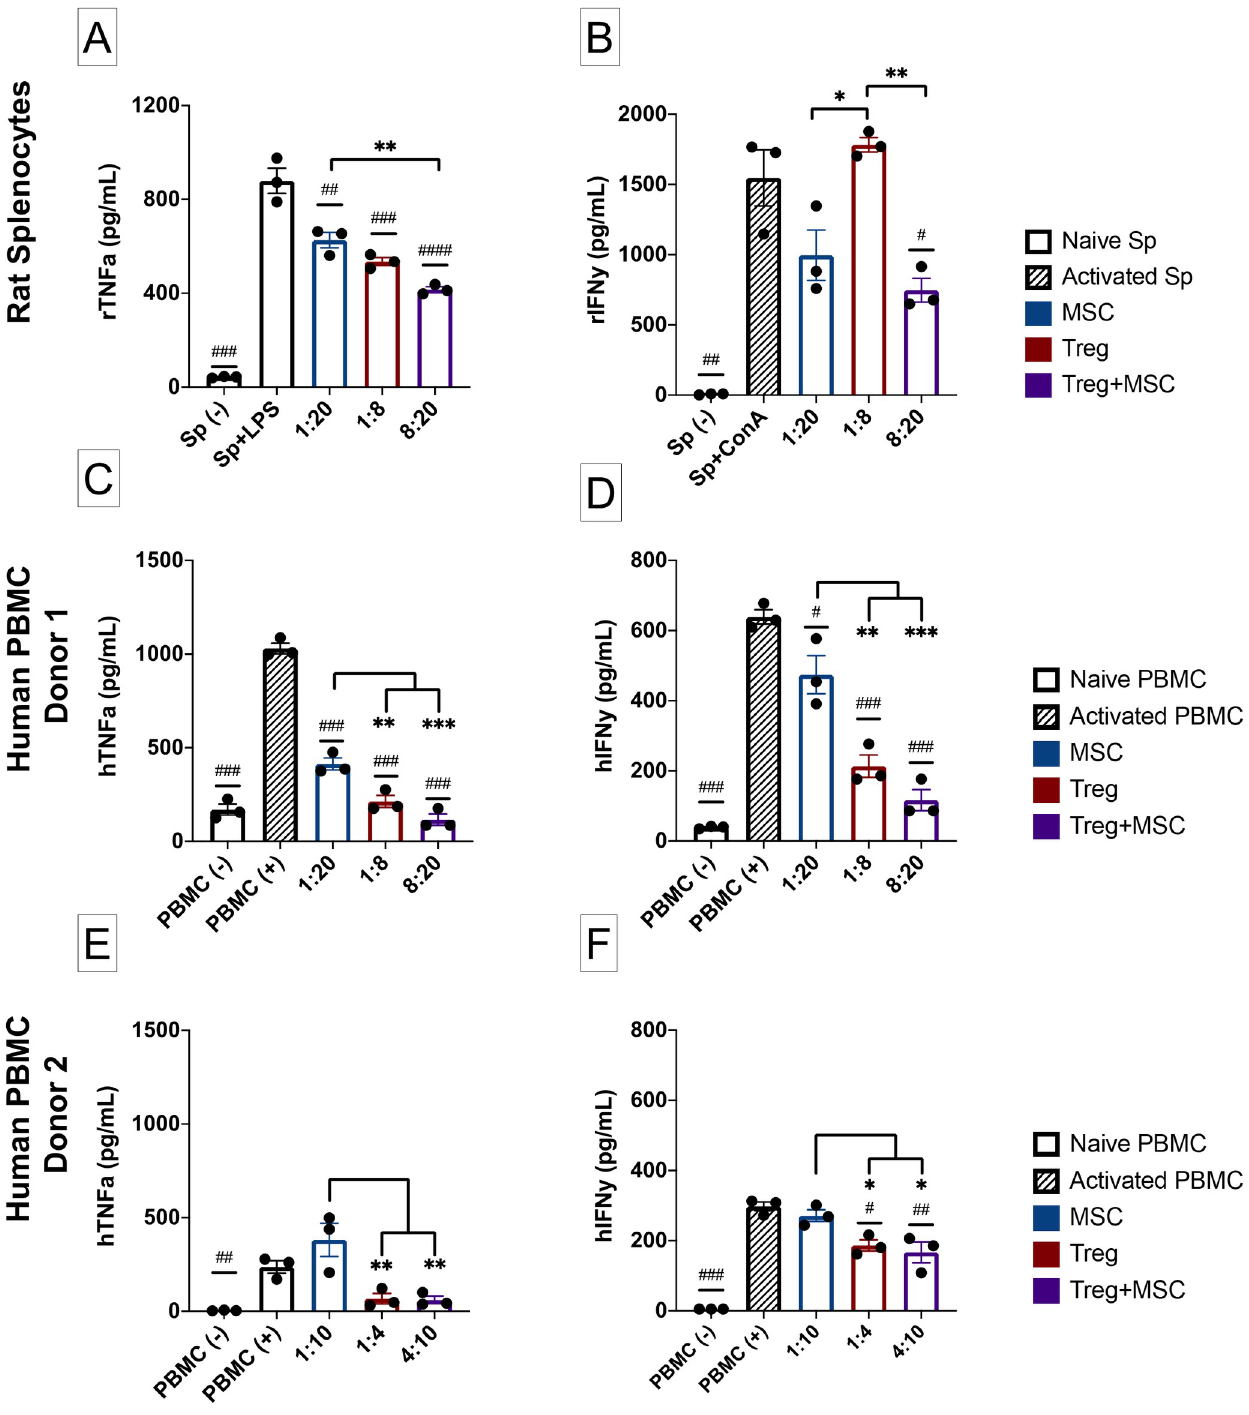
Fig 4. Characterization of immune suppressive potential of MSC, Treg, and Treg+MSC on activated rat splenocytes and human PBMC in vitro. (A) : TNF-a production (ELISA) by rat splenocytes after LPS stimulation. (B) : IFNy production (ELISA) by rat splenocytes after ConA stimulation. (C-D) : Pro- inflammatory cytokine production, TNFa (C) and IFNy (D) by activated human Donor 1 PBMC after anti-CD3/CD28 bead stimulation (ELISA). (E-F) : Pro- inflammatory cytokine production, TNFa (E) and IFNy (F) by activated human Donor 2 PBMC after anti-CD3/CD28 bead stimulation (ELISA). All samples run in triplicate. Statistical significance between naive/treatment and activated control is indicated with (#) for p � 0.05, (##) for p � 0.01, (###) for p � 0.001. Statistical significance between treatment groups is indicated with ( � ) for p � 0.05, ( �� ) for p � 0.01, ( ��� ) for p � 0.001. Treg, regulatory T cell; MSC, mesenchymal stromal cell; PBMC, peripheral blood mononuclear cells; TNFa, tumor necrosis factor alpha; IFNy, interferon gamma; ELISA, enzyme- linked immunosorbent assay. https://doi.org/10.1371/journal.pone.0251601.g004 PLOS ONE | https://doi.org/10.1371/journal.pone.0251601 May 26,